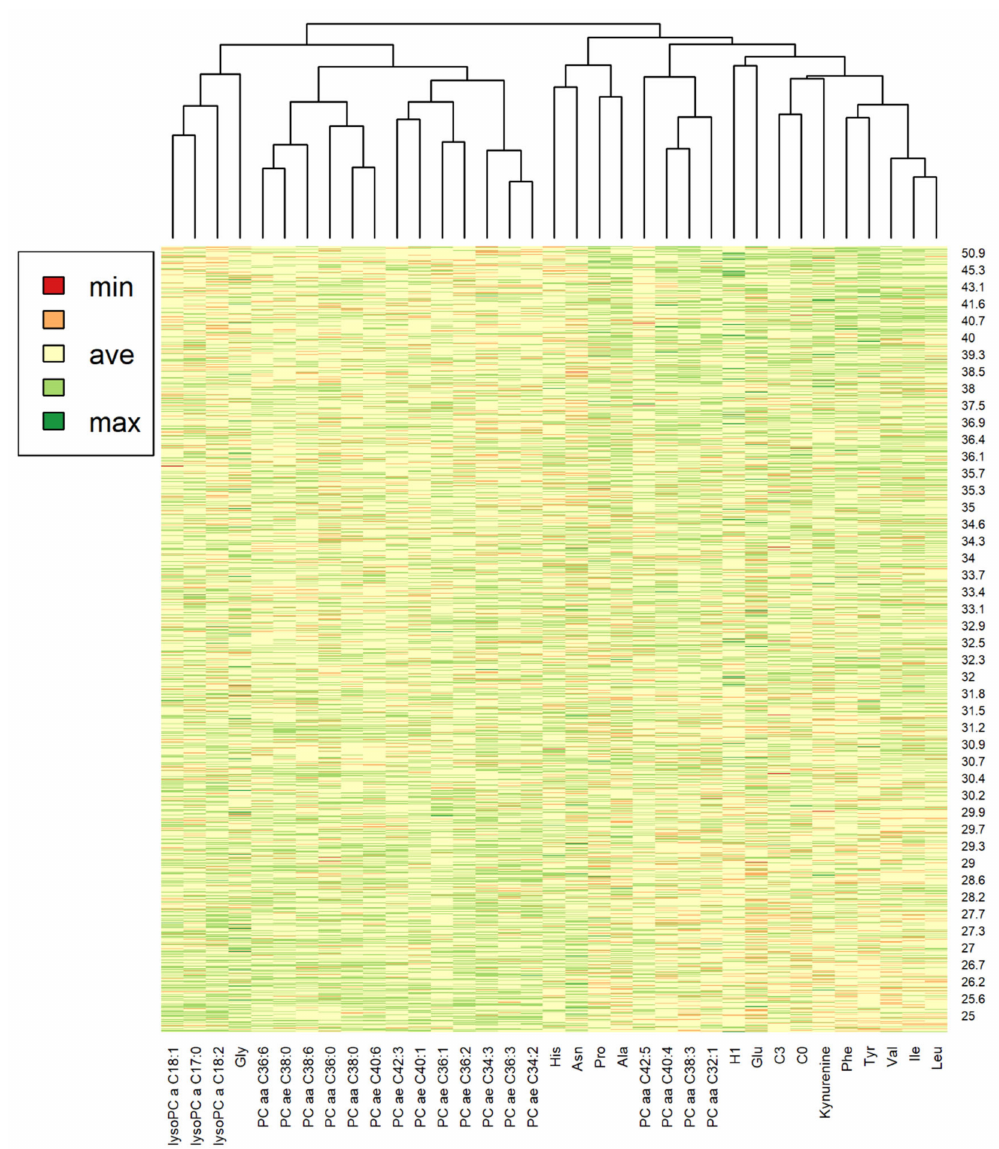
Figure 5. Heat map showing metabolite levels among subjects. The subjects were sorted by BMI. Only the most significant metabolites in the Tobit models for BMI (FDR p -value < 0.0001) were considered and they were grouped with a cluster analysis. Dendrograms built with Euclidean distances related to the cluster analysis are reported